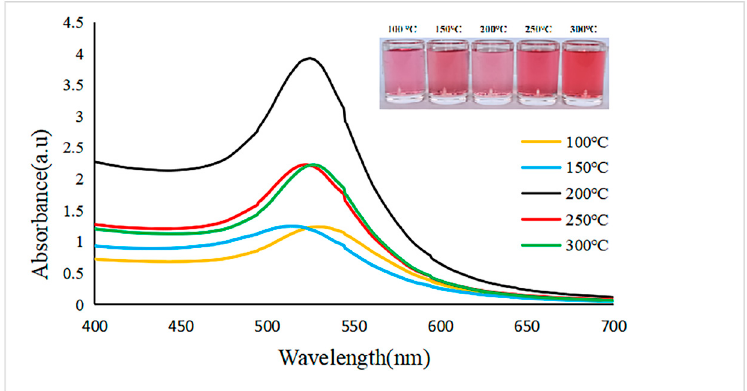
Figure 4. Ultraviolet – visible absorption spectra and colloid color diagram of gold nanoparticles prepared at different reaction temperatures.